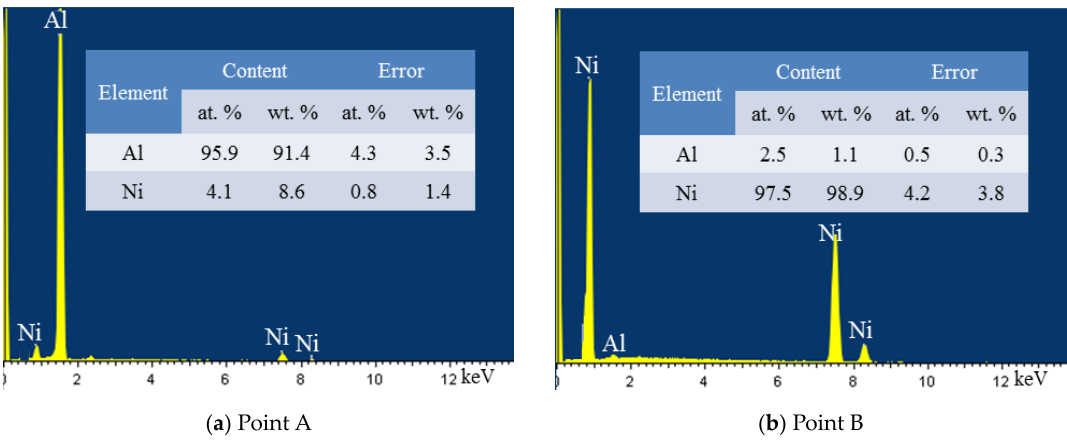
Figure 1. Micromorphology ( a ) and partially enlarged details ( b ) of Ni80Al20 alloy powder.